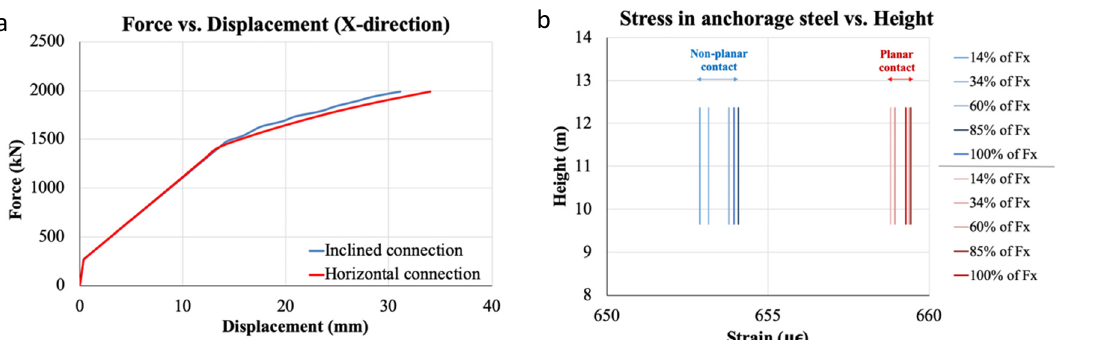
Figure 13. Influence of the concrete ‐ concrete contact geometry on the (a) force vs. displacement and (b) stress level on the steel connectors during the loading process.